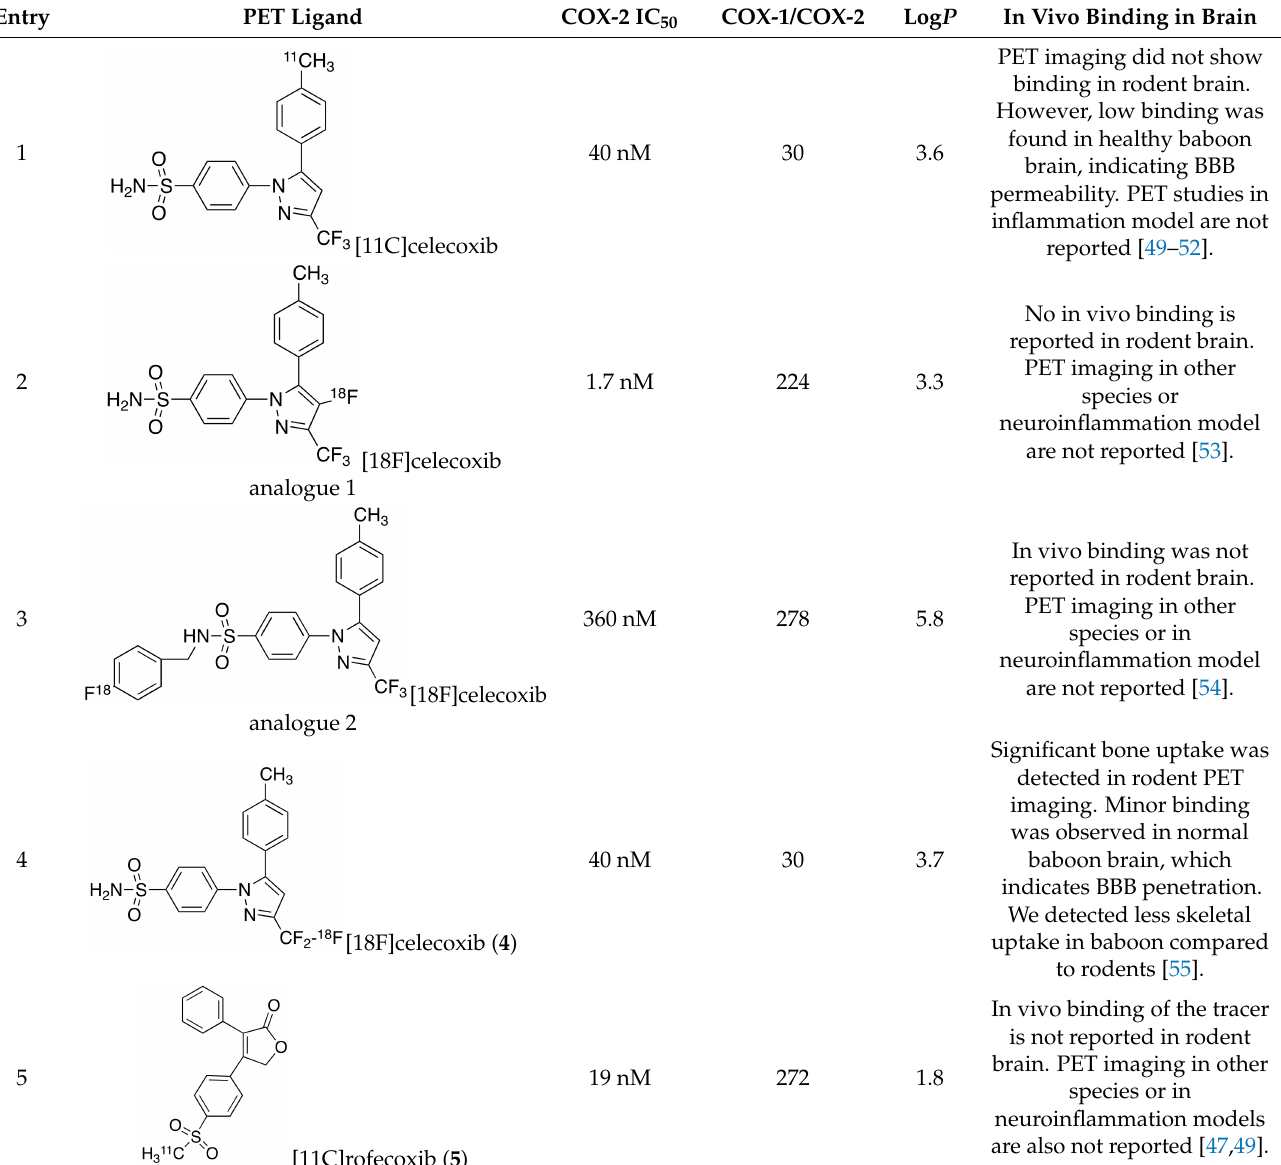
Table 1. [11C] and [18F]-labeled radioligands developed in the past decade for PET imaging